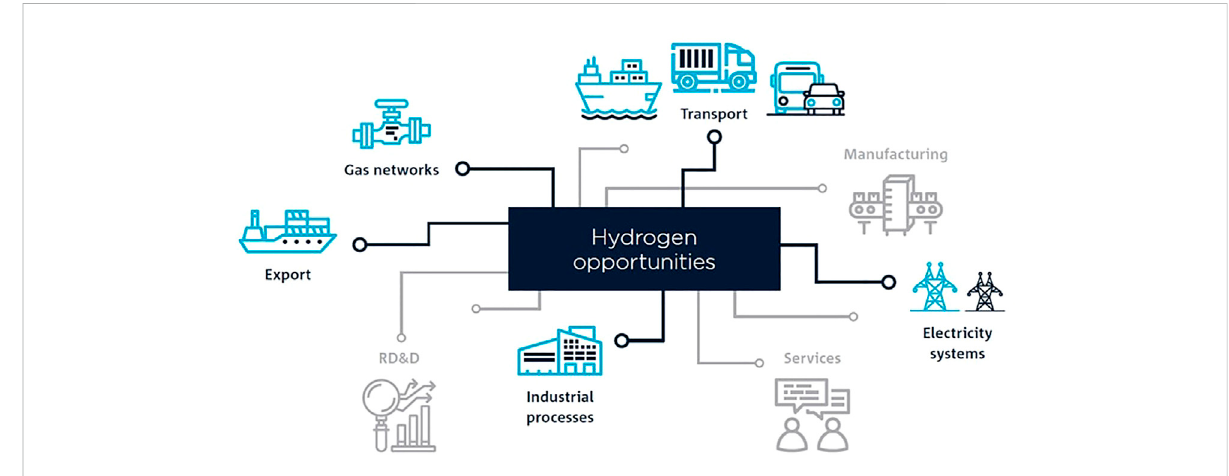
FIGURE 2 The range of role and use of hydrogen across the energy and transport sector (from Srinivasan et al.,